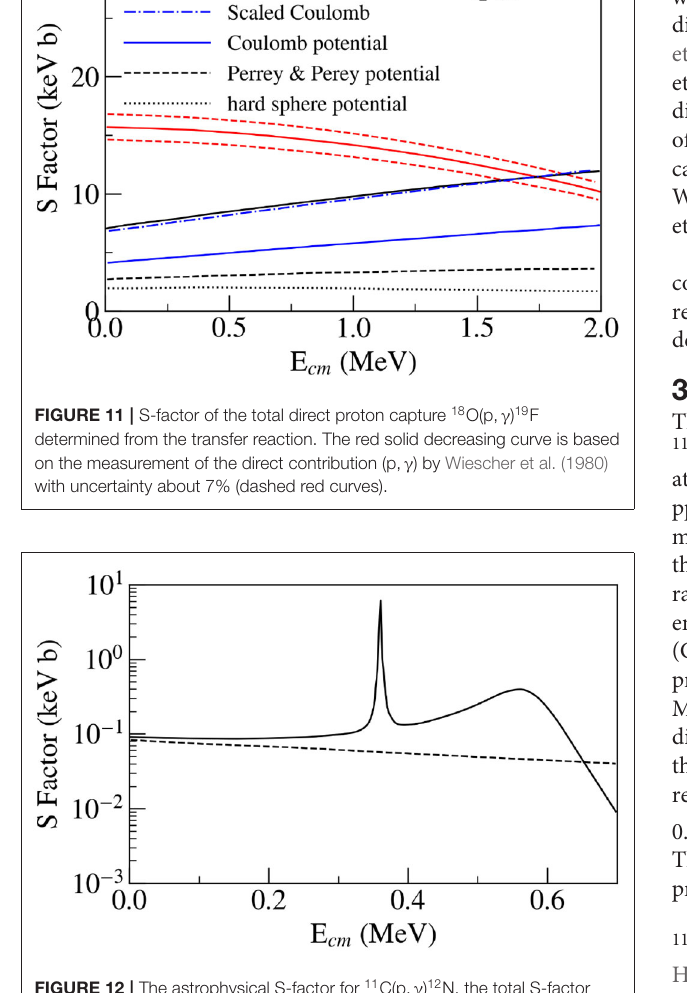
FIGURE 12 | The astrophysical S-factor for 11 C(p, γ ) 12 N, the total S-factor (solid line) and the direct contribution alone (dotted